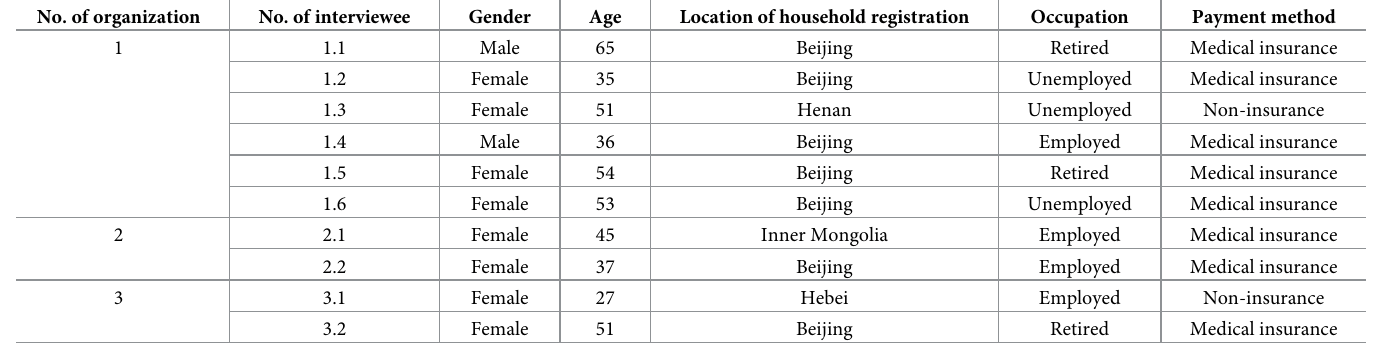
Table 1. Participant